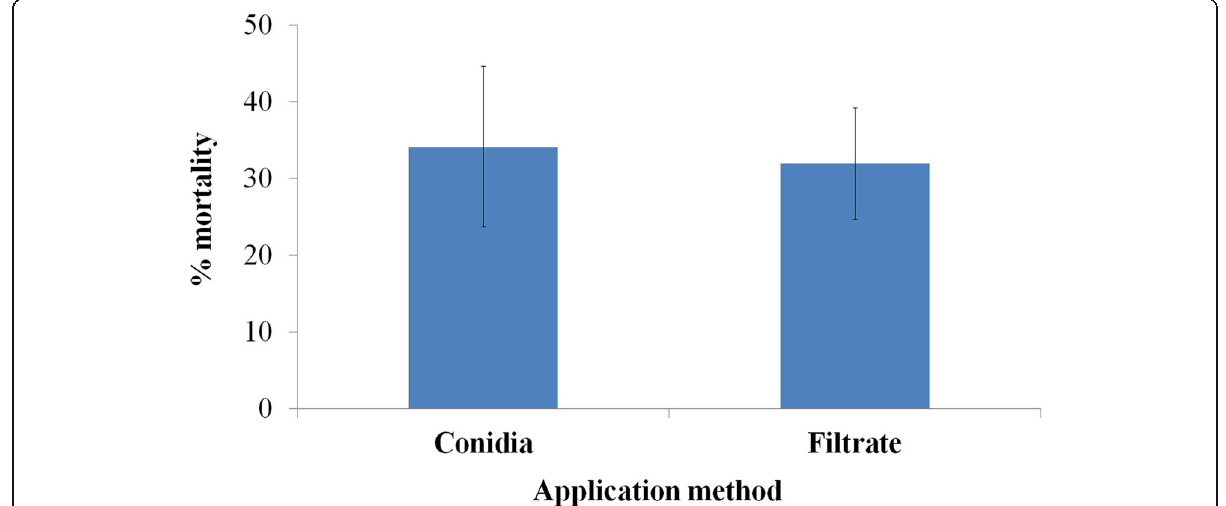
Fig. 1 Overall effect of conidial and filtrate application of fungal isolates on Myzus persicae